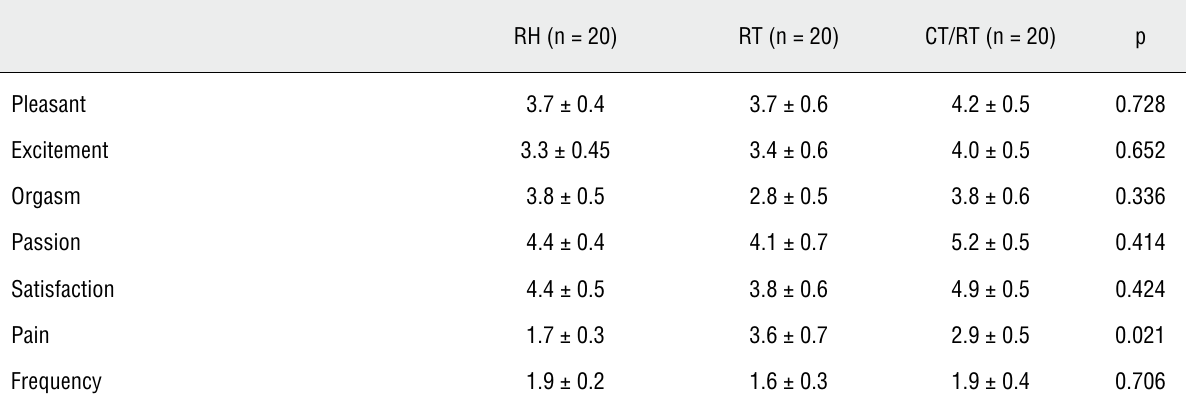
Table 4 - Sexual symptoms according to treatment type.